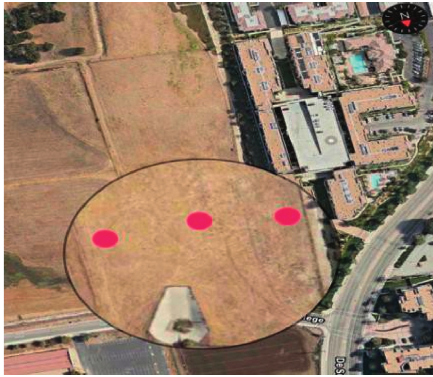
Figure 2: Sampling locations for Field 19 soil classification survey. Table 4: Selected metadata for Pierce College 16S